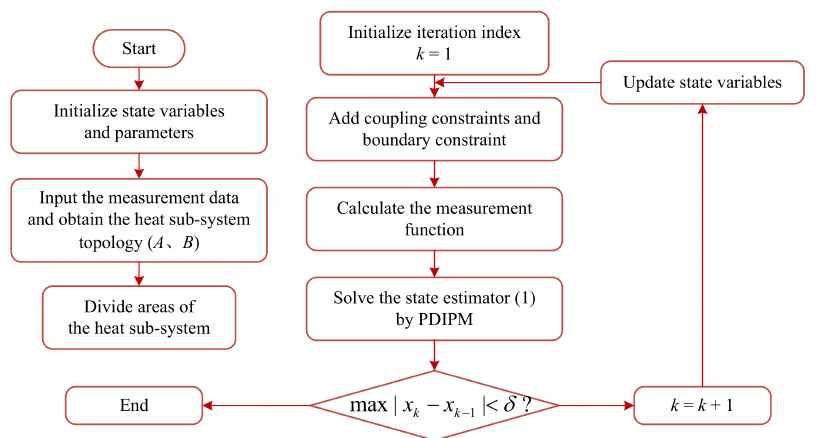
Figure 5. Flowchart of the state estimation approach of IEHN. PDIPM: primal-dual interior point